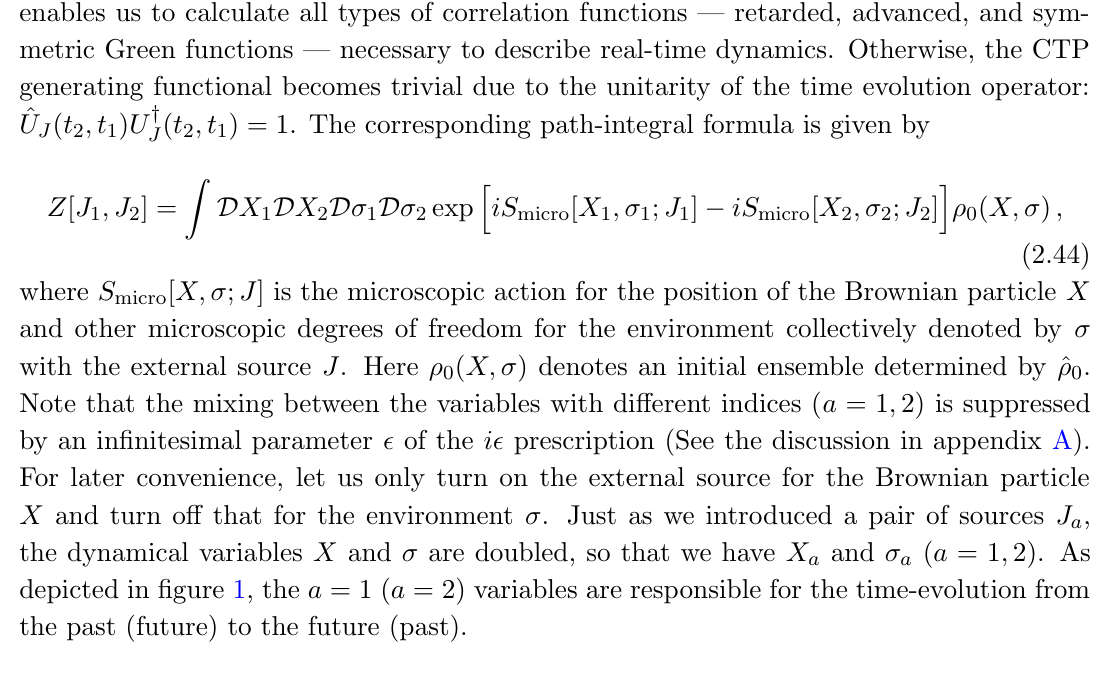
e (cid:0) (cid:12) ^ H , we have /